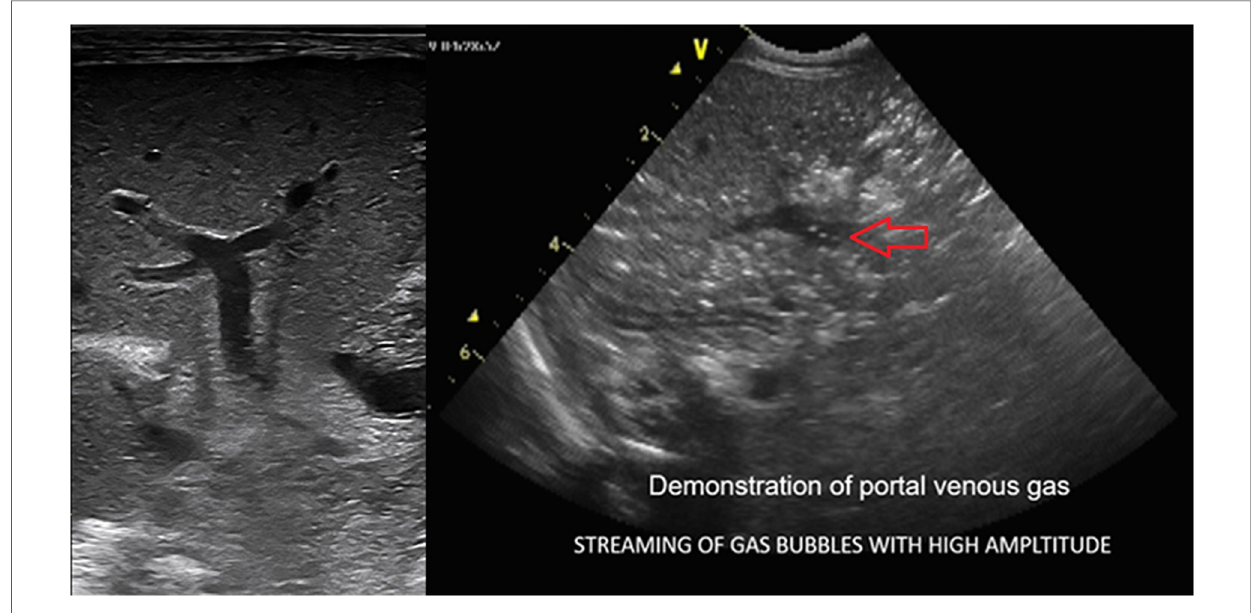
FIGURE 8 The sonographic appearance demonstrating real-time visualization of portal venous gas release seen as bright echogenic dots (streaming of gas bubbles through the portal vein). The entrapment of these bubbles within the porto-hepatic venous architecture results in abnormal hepatic echotexture seen as interspersed bright echogenic dots as opposed to the normal homogenous hepatic echotexture of a normal Liver.